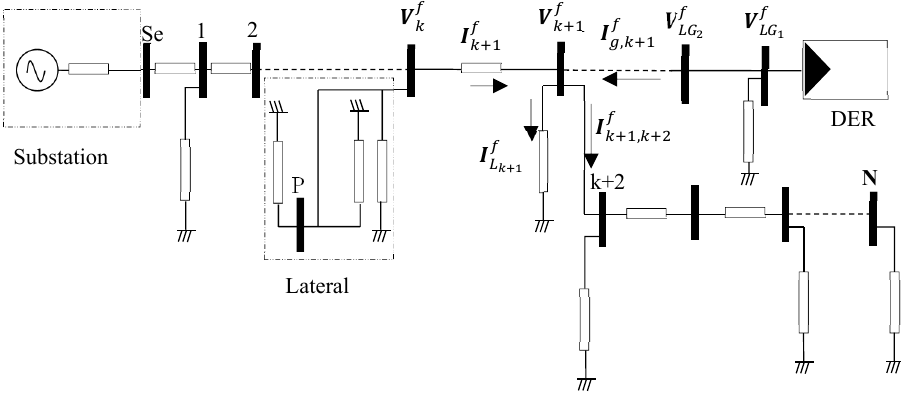
Figure 10. Update of the current for the node where the lateral of the DER is connected.